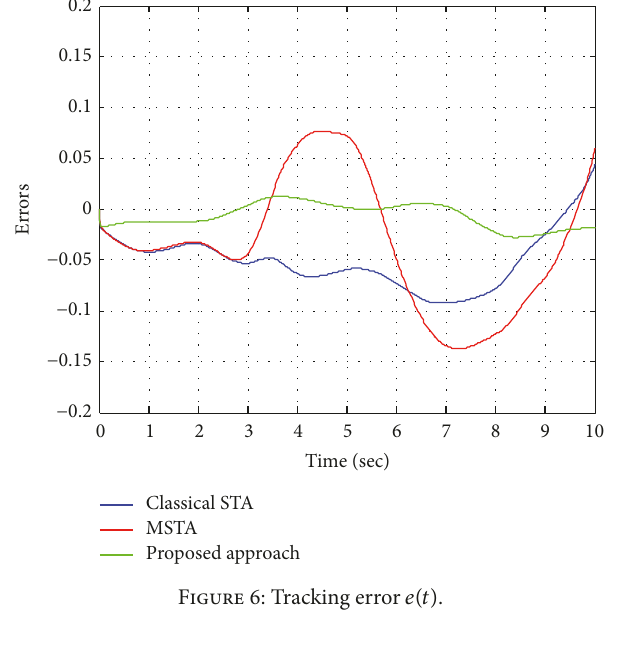
Figure 6: Tracking error 𝑒(𝑡) .